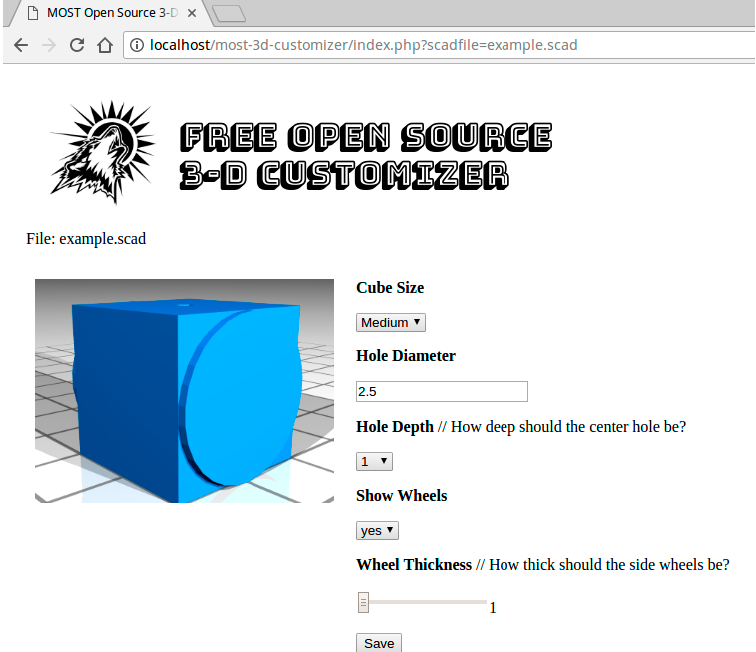
Figure 2. The initial page of Free and Open Source 3-D Customizer loading the example SCAD file from Section 2.3.